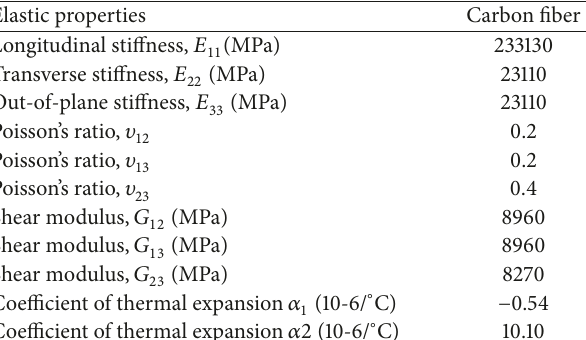
Table 2: Carbon fiber properties at room temperature used for the numerical simulations.